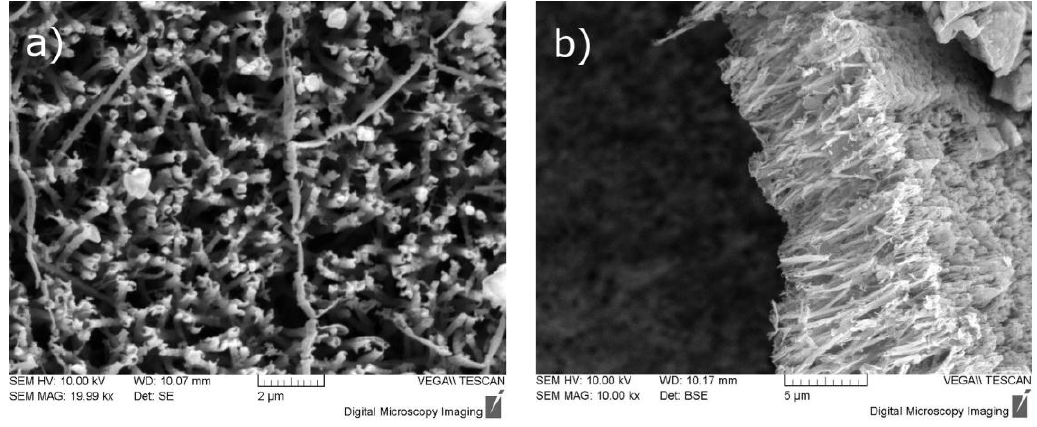
Figure 2. SEM image of a TiO 2 NWA ( a ) top-view; ( b ) lateral